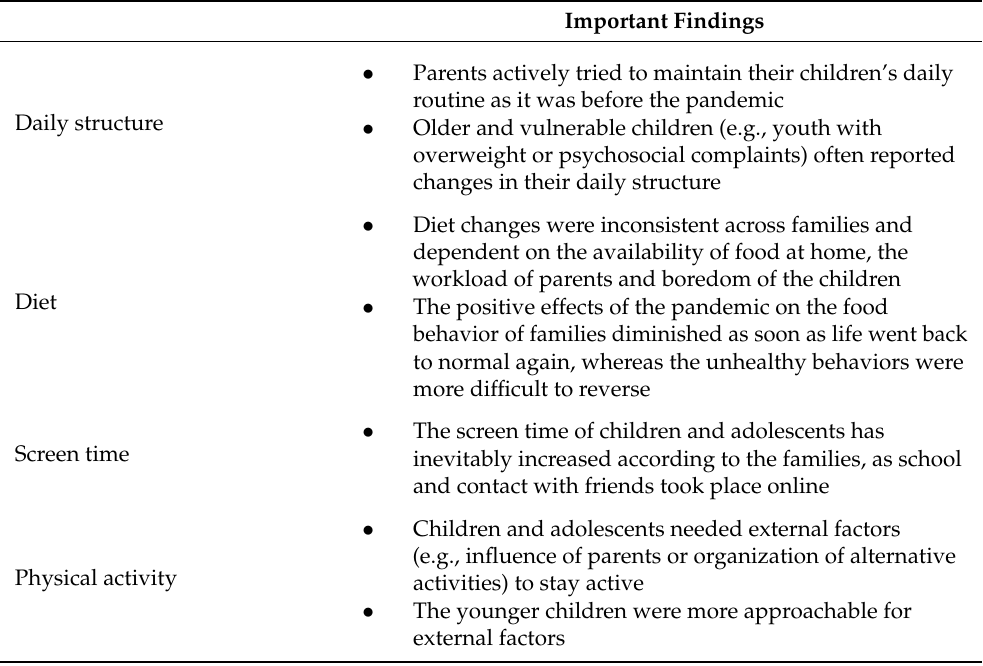
Table 2. Important findings with regard to the lifestyle of families during the COVID-19 pandemic. Important